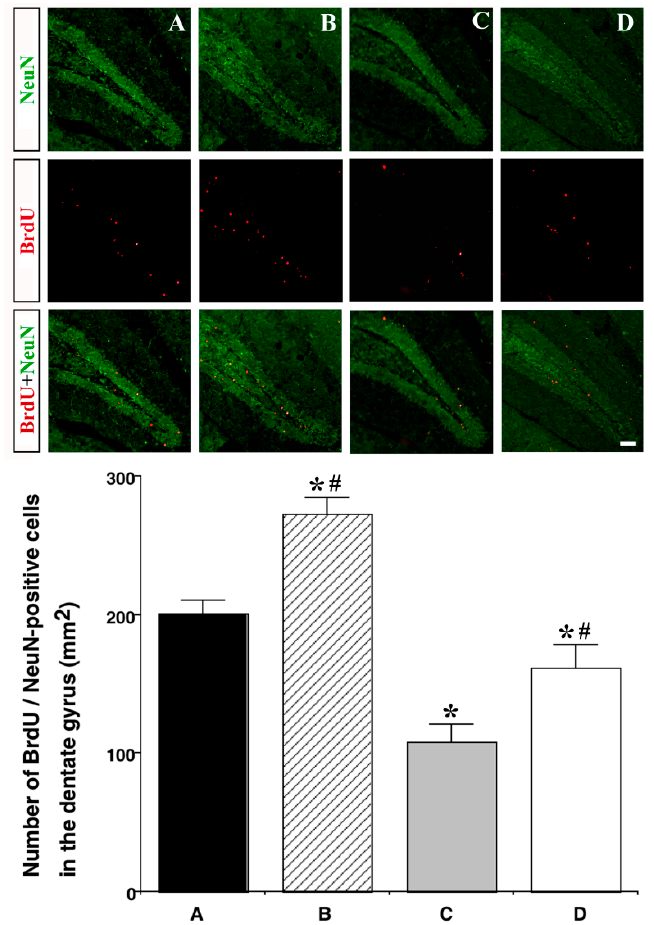
Figure 5. Effect of treadmill exercise on neurogenesis in the hippocampal dentate gyrus. (Above) Photomicrographs of BrdU/NeuN-double-positive cells. The scale bar represents 100 µm. (Below) The number of BrdU/NeuN-double-positive cells in each group. Control group A , control and exercise group B , high-fat diet group C , and high-fat diet and exercise group D . Data are expressed as the mean ± S.E.M. * Represents p < 0.05 as compared with the control (CON) group. # Represents p < 0.05 as compared with the high-fat diet (HFD) group.